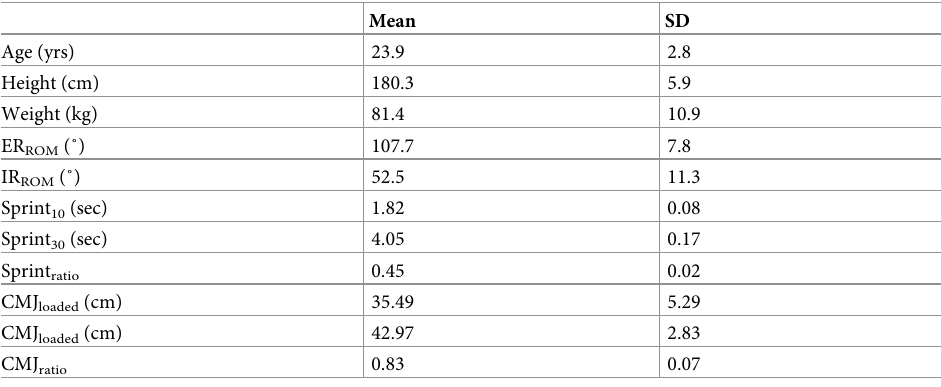
Table 1. Anthropometric, physical parameters and field test